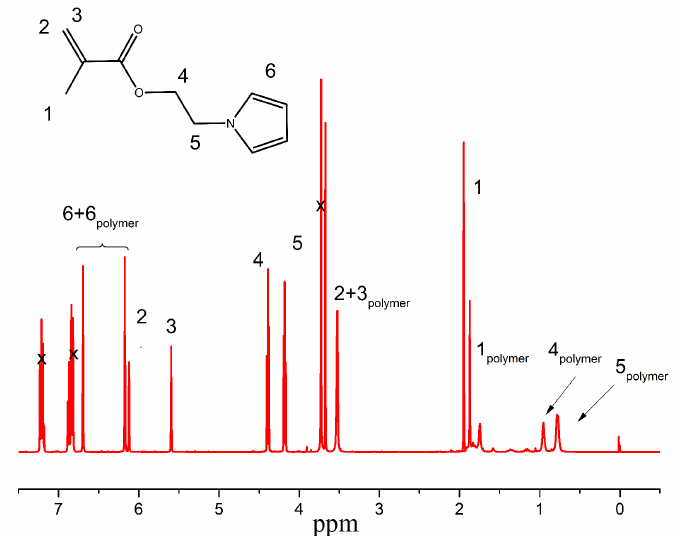
Figure 1. 1 HNMR spectra of the PPEMA polymer grafted from the surface of carbonyl iron. x representing the peaks of various solvents present in the reaction mixture.